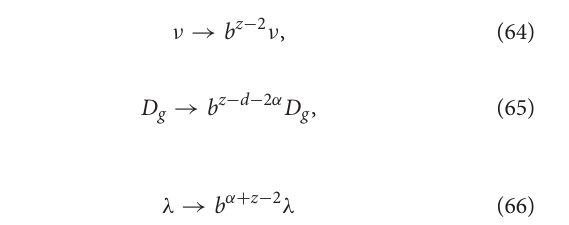
FIGURE 6 | (Color online) (A) Fire propagation in the Amazon rainforest. Source: http://g1.globo.com/am/amazonas/noticia/2013/01/florestas-no-sul-do-am-estao- mais-vulneraveis-incendio-aponta-estudo.html; (B) Schematic representation on a microscopic scale of the height evolution h ( x for a given time t media, as function of the position E